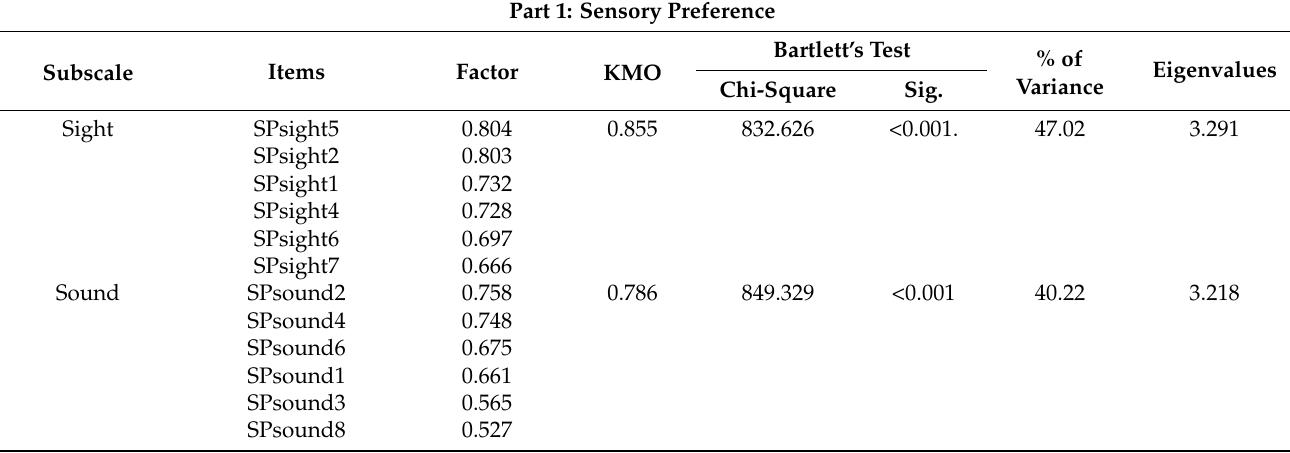
Table 2. Factor loading of part 1: sensory preference. Part 1: Sensory